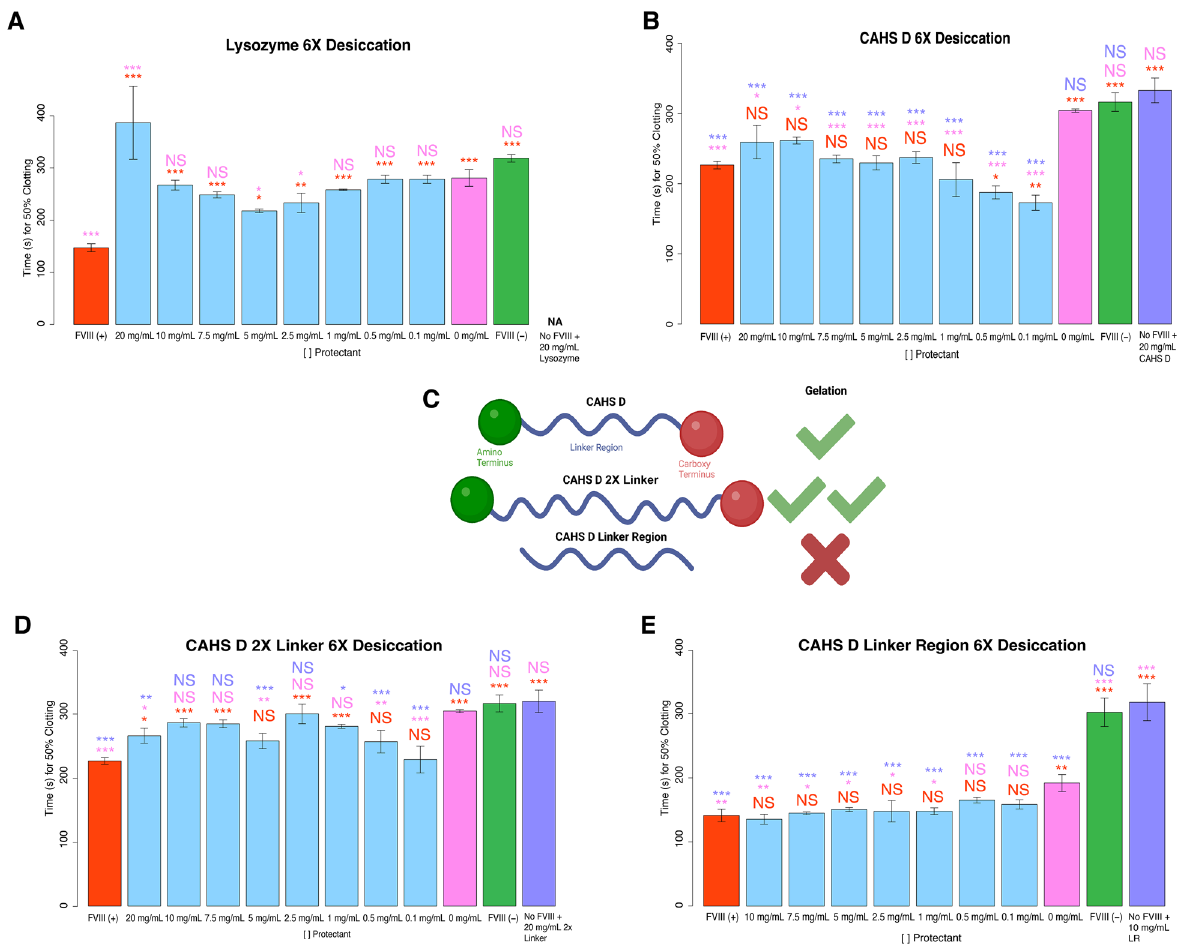
Figure 3. Protective capacity of natural and engineered CAHS D variants during repeated desiccation cycles. Histograms of the 50% clotting time of FVIII after various treatments with a ( A ) control protein lysozyme, ( B ) CAHS D, ( D ) CAHS D 2X Linker and ( E ) CAHS D Linker Region, subjected to repeated desiccation cycles. The red “FVIII (+)” bar represents FVIII deficient human blood plasma treated with FVIII. All red notations above sample bars represent statistical comparison with “FVIII (+).” “X mg/mL” notations beneath sample bars correspond to the concentrations of protein mixed with FVIII before desiccation. All pink notations above sample bars represent statistical comparison with “0 mg/mL.” The green “FVIII (−)” bar represents FVIII deficient human blood plasma treated with no FVIII. “No FVIII + X mg/mL protein” represents FVIII deficient human blood plasma treated with X mg/mL protein, but no FVIII. All purple notations above sample bars represent statistical comparison with “No FVIII + X mg/mL protein.” Notations above sample bars represent statistical significance determined by one-way ANOVA and Tukey’s post-hoc test. Error bars represent bi-directional standard deviation. P value > 0.05 = NS, P < 0.05 = *, P < 0.01 = **, P < 0.001 = *** ( C ) Schematic depiction of CAHS D, CAHS D 2X Linker, and CAHS D Linker Region protein ensembles and an indication of whether these proteins form